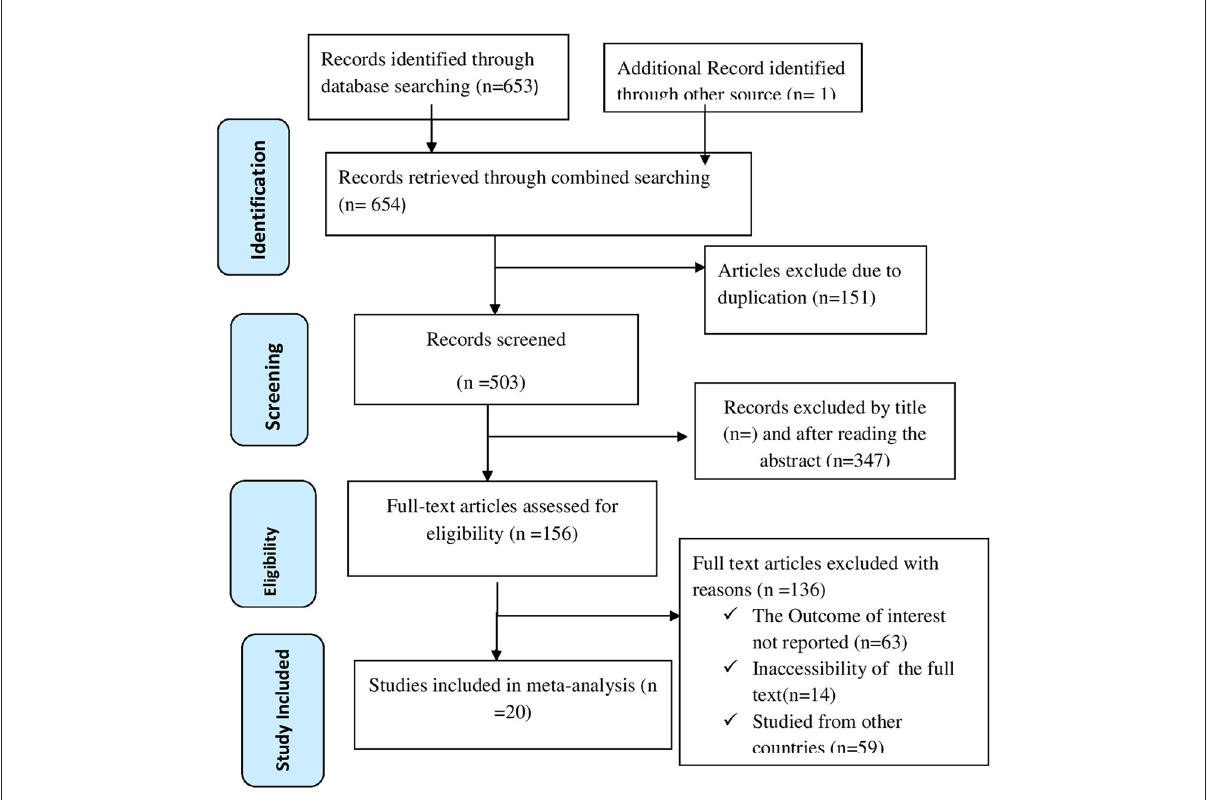
year of publication, study region, study setting, study